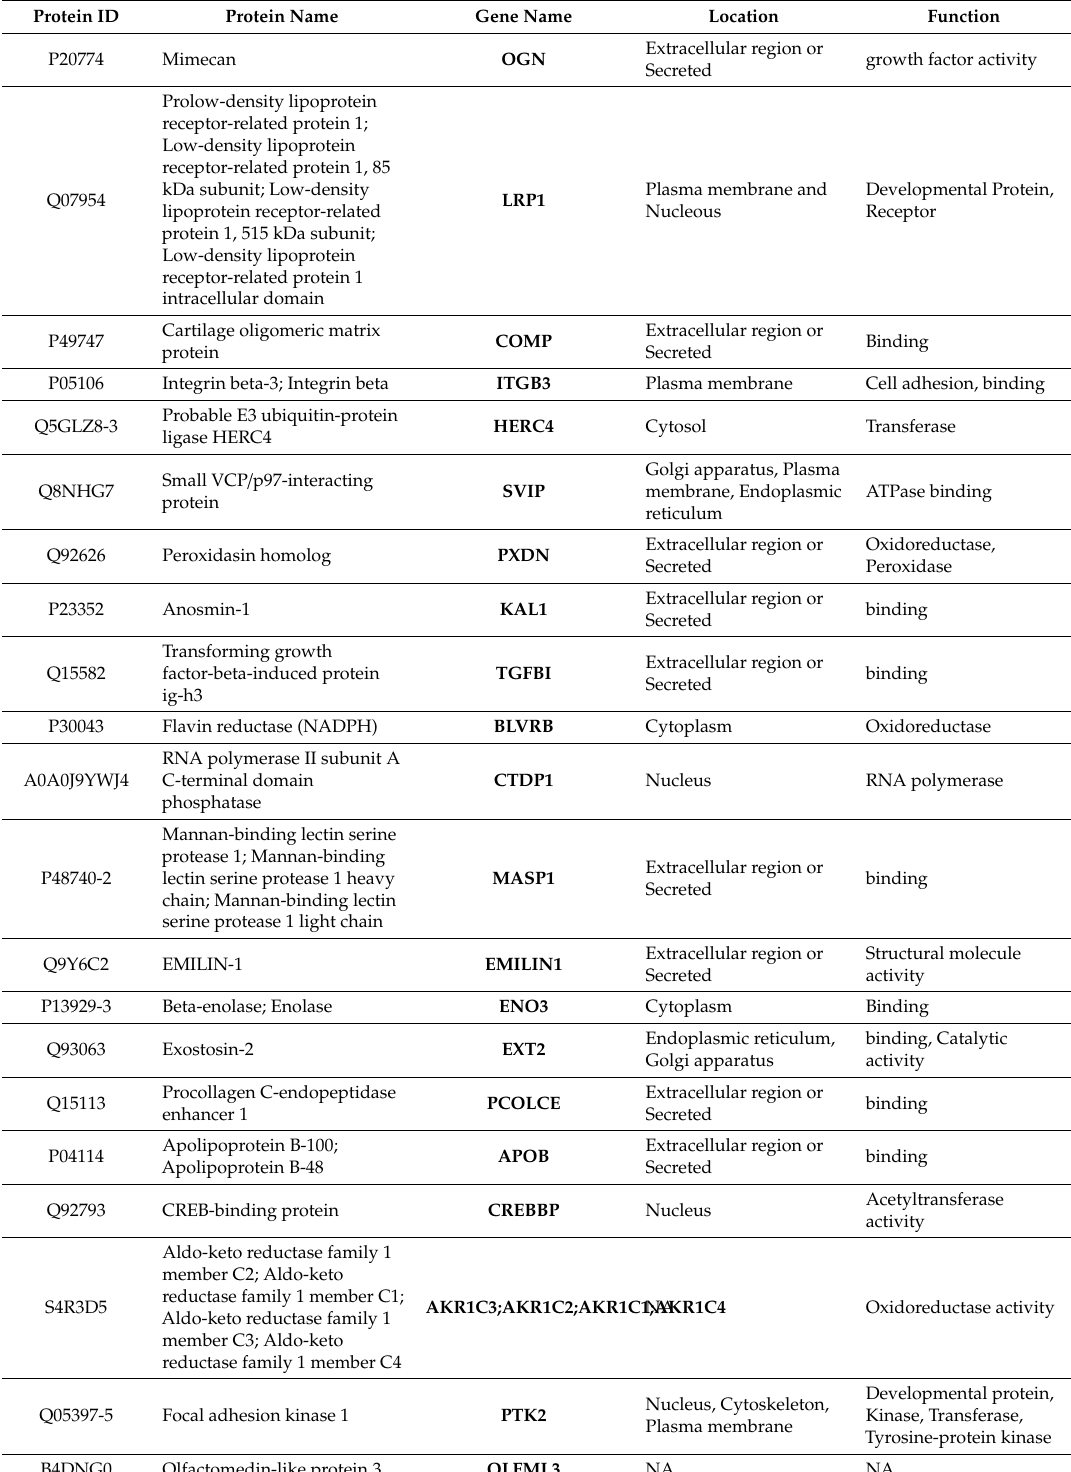
Table 2. Name, cellular location and function of proteins exclusively present in RBVS derived